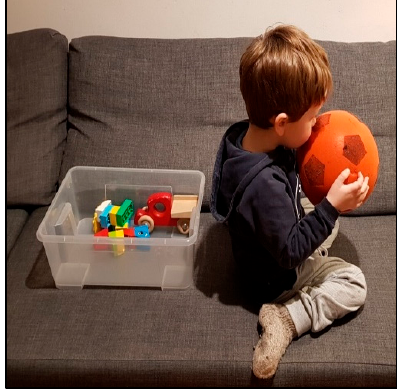
Figure 2. Picture associated with (33) .